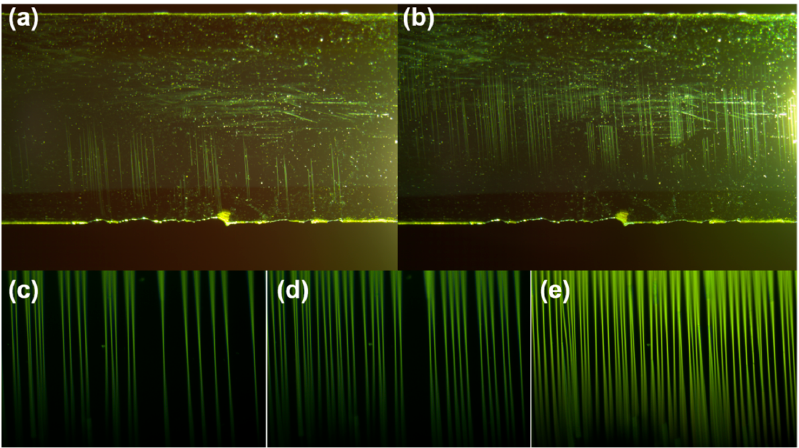
Figure 8. ( a ) Initial cracks, ( b ) perforated cracks of real-time monitoring image of cracks in SiN x film and ( c – e ) at higher strain midpoint cracking begins and increases.